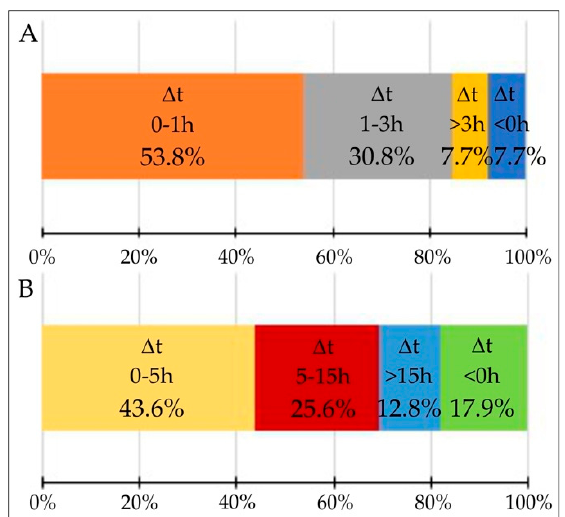
Figure 10. Distribution in % of the summer ( A ) and spring-autumn ( B ) events based on the period Δ t (in h) between the time of the maximum recorded peak of rainfall intensity and the time of landslide occurrence. Δ t < 0 h represents the period before the maximum rainfall peak.